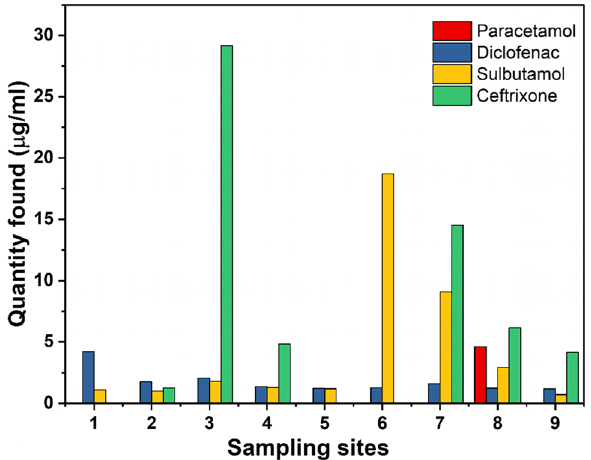
Fig. 3 Quantities of pharmaceuticals recovered from